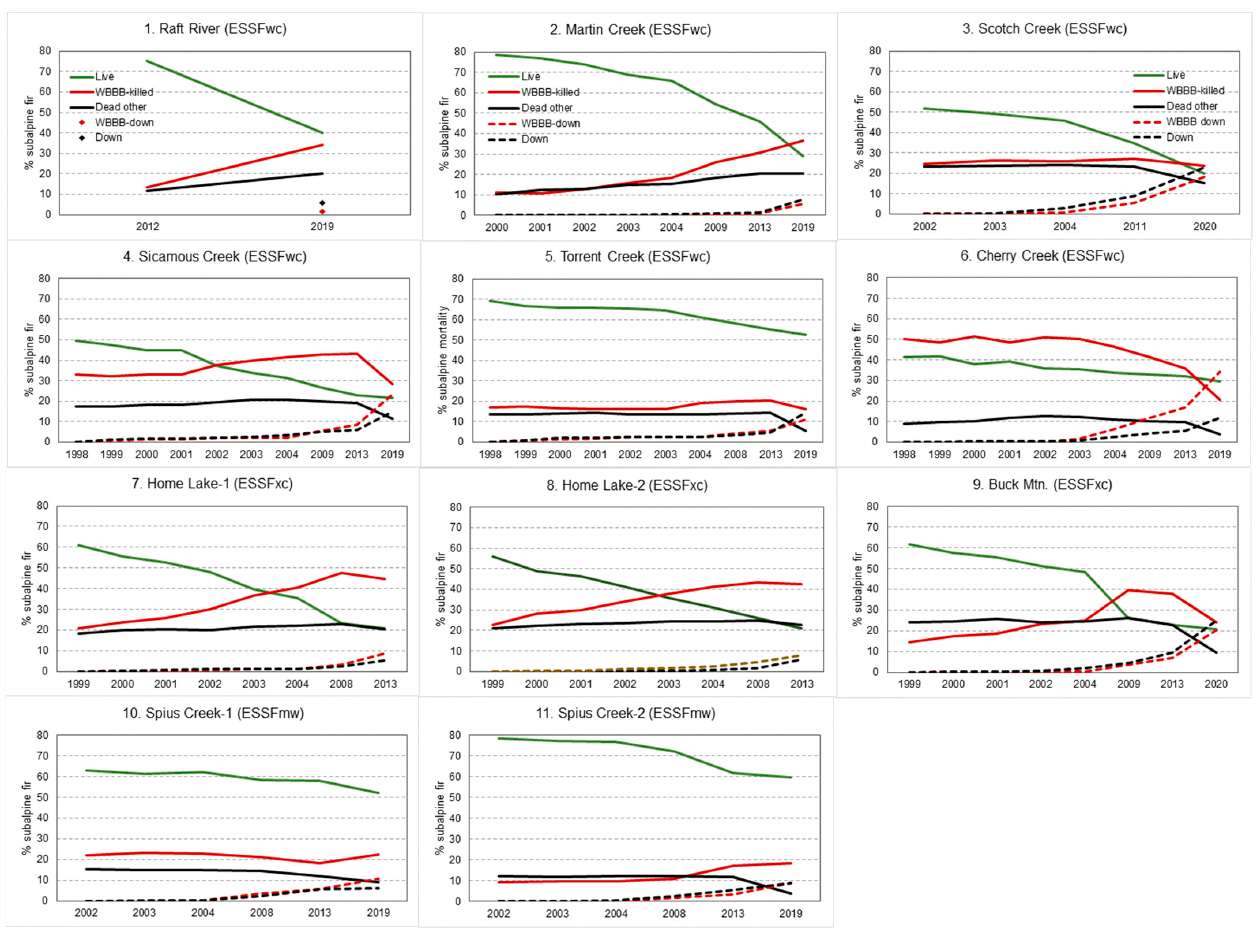
Figure 2. Status of subalpine fir over time in 11 plots showing the percentage of live subalpine firs, the percentage killed by D. confusus (WBBB-killed), the percentage killed from other damage agents (dead other), the percentage killed by D. confusus that had fallen (WBBB-down), and the percentage that fell while still alive or were killed by other damage agents (down).